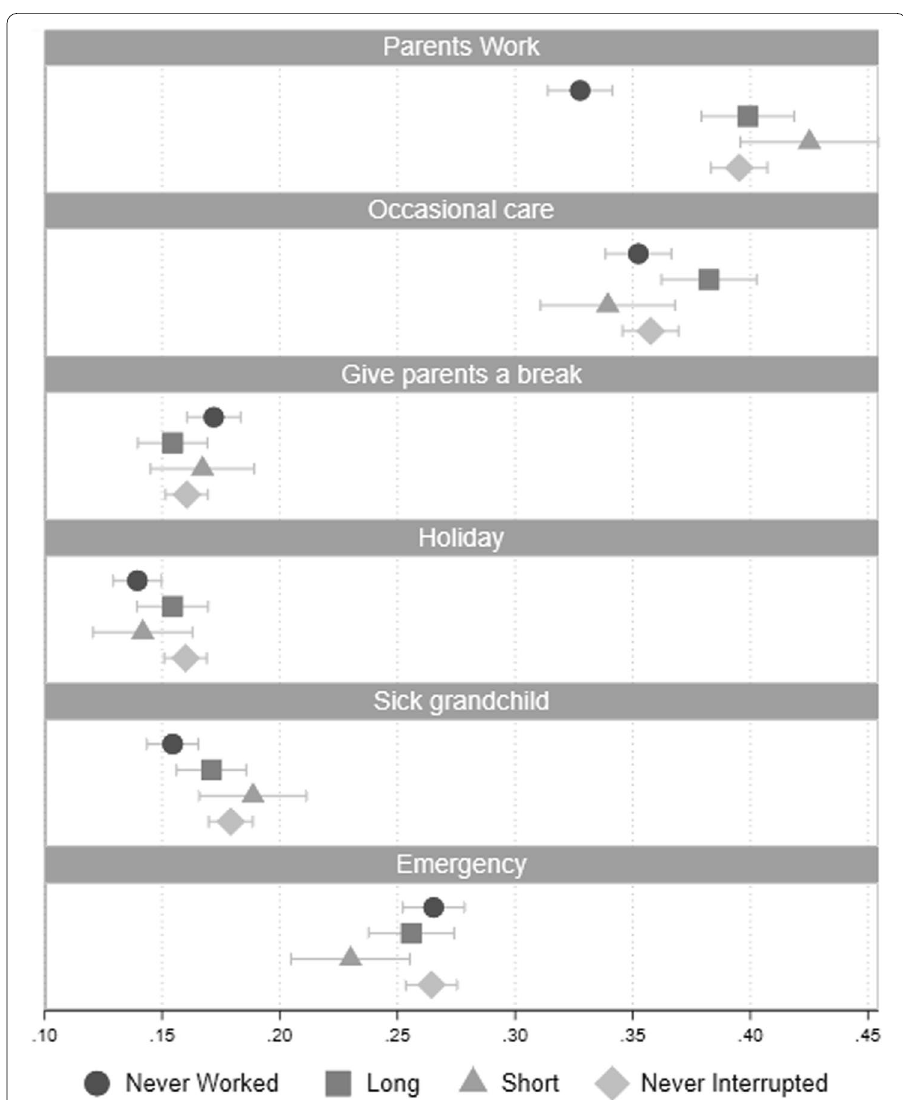
Fig. 5 Predicted probabilities ( x -axis) to perform grandparental childcare under different circumstances, by grandmothers’ work history: Interruptions for family-related reasons. Results from logistic regression models, control variables included: age; occupational status; birth cohort; educational level; area of residence. CI for approximate 5% significance level for the comparison of pairs of predicted probabilities. Source : Authors’ elaborations on Multipurpose surveys on Families and Social Subjects—ISTAT, 2003, 2009, 2016. N